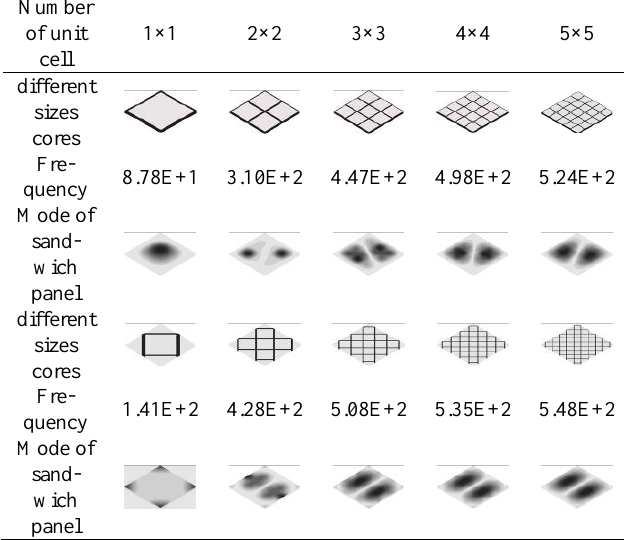
The finite element models of sandwich panels with rent size square and rhombic cores and the hom nized cores are built and their five order eigen-frequencies vibration modes are calculated as shown in Table 18 and Fig.21 to Fig.25. Table 14. The first order vibration response with the dif- ferent size square a d rhombic cores n